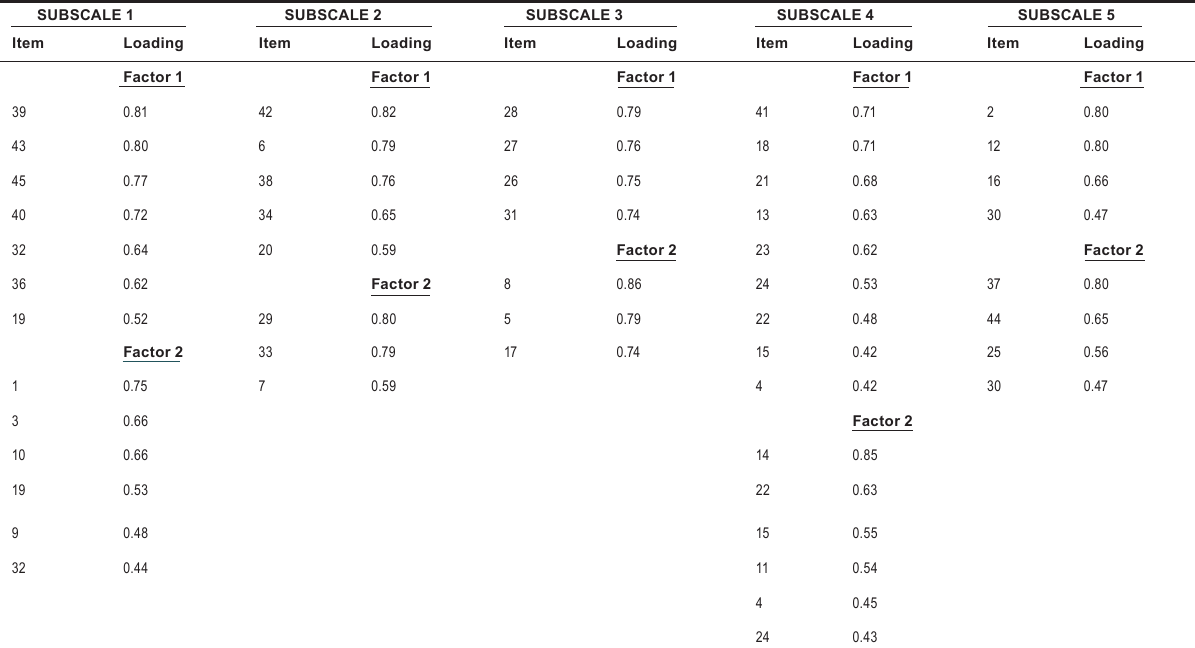
table 6 Factor loadings for the subscales of the Hopkins Symptom